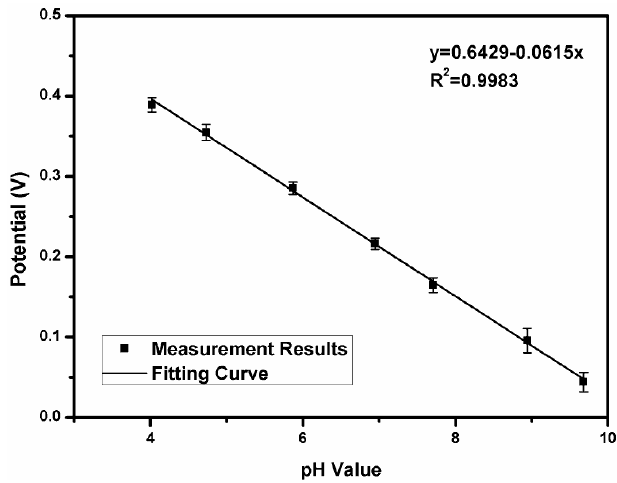
Figure 16. pH value versus the detected potential signals.